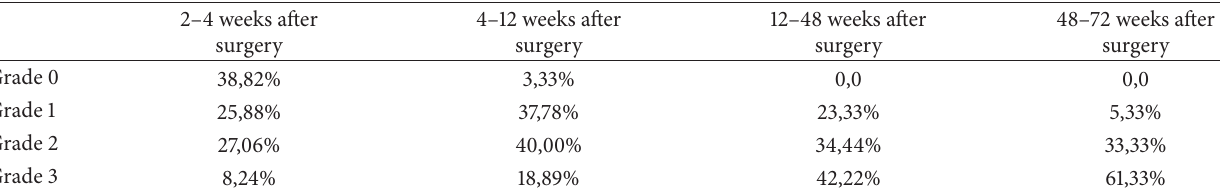
Table 3: The percentage distribution of the IS/OS reflectivity in SdOCT cross-sectional scan running through the foveolar center in relation to follow-up